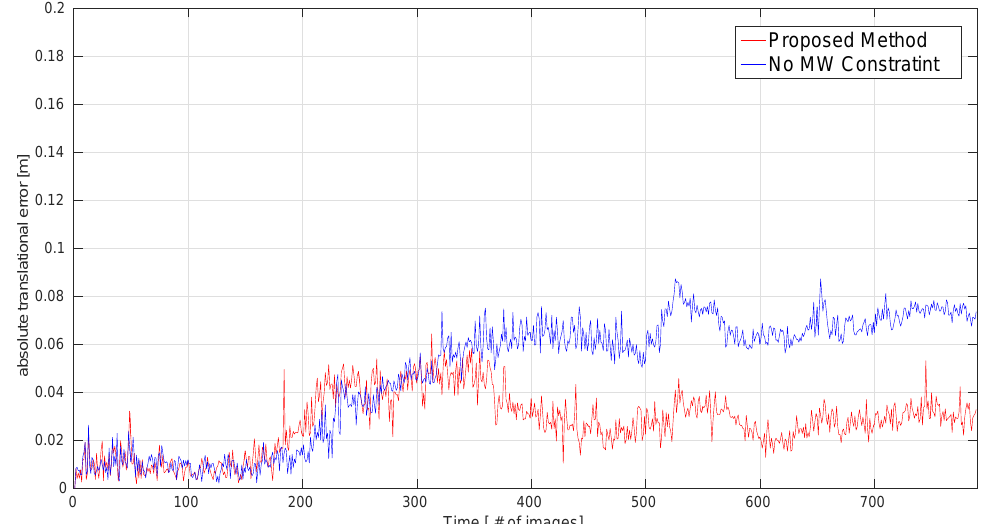
Figure 9. Performance evaluation for the MW constraint on the ’fr3_struc_notex_far’ sequence. Absolute translational errors for our proposed method with and without the MW constraint are